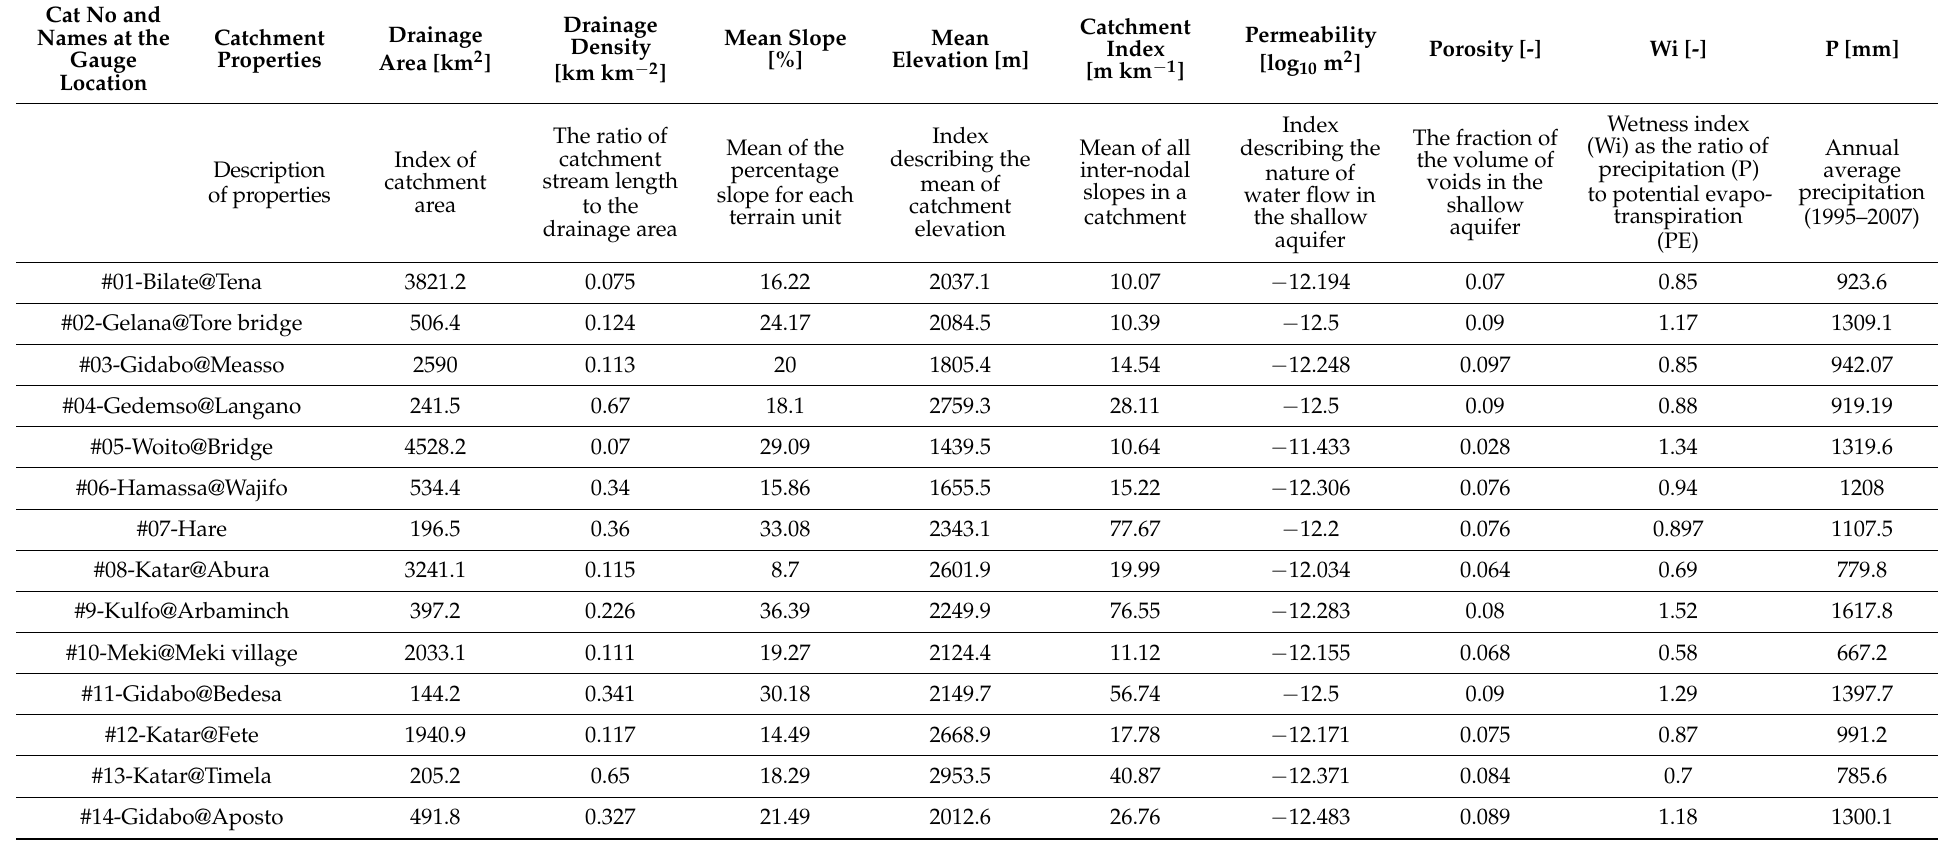
Table 2. Descriptions and values of properties for gauged catchments in the RVLB that were used for the development of the regional